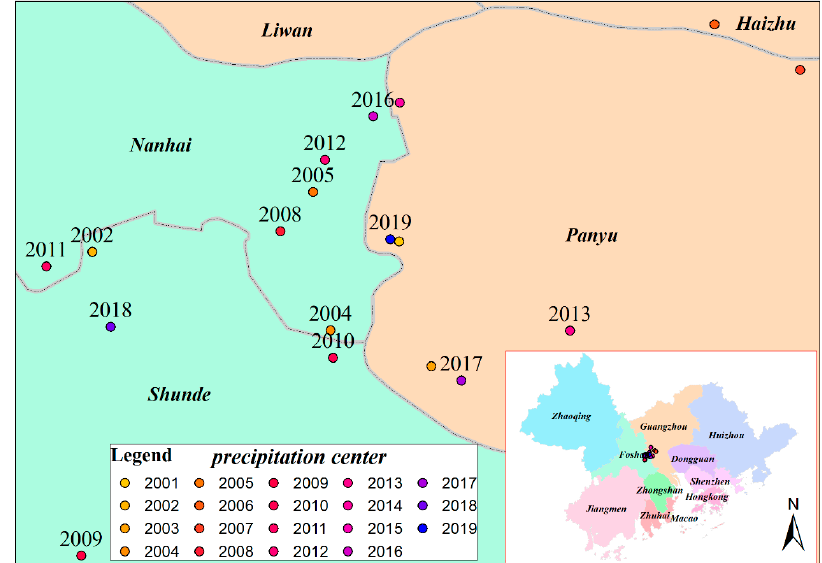
Figure 9. Spatial distribution of precipitation centers in the GBA from 2001 to 2019.